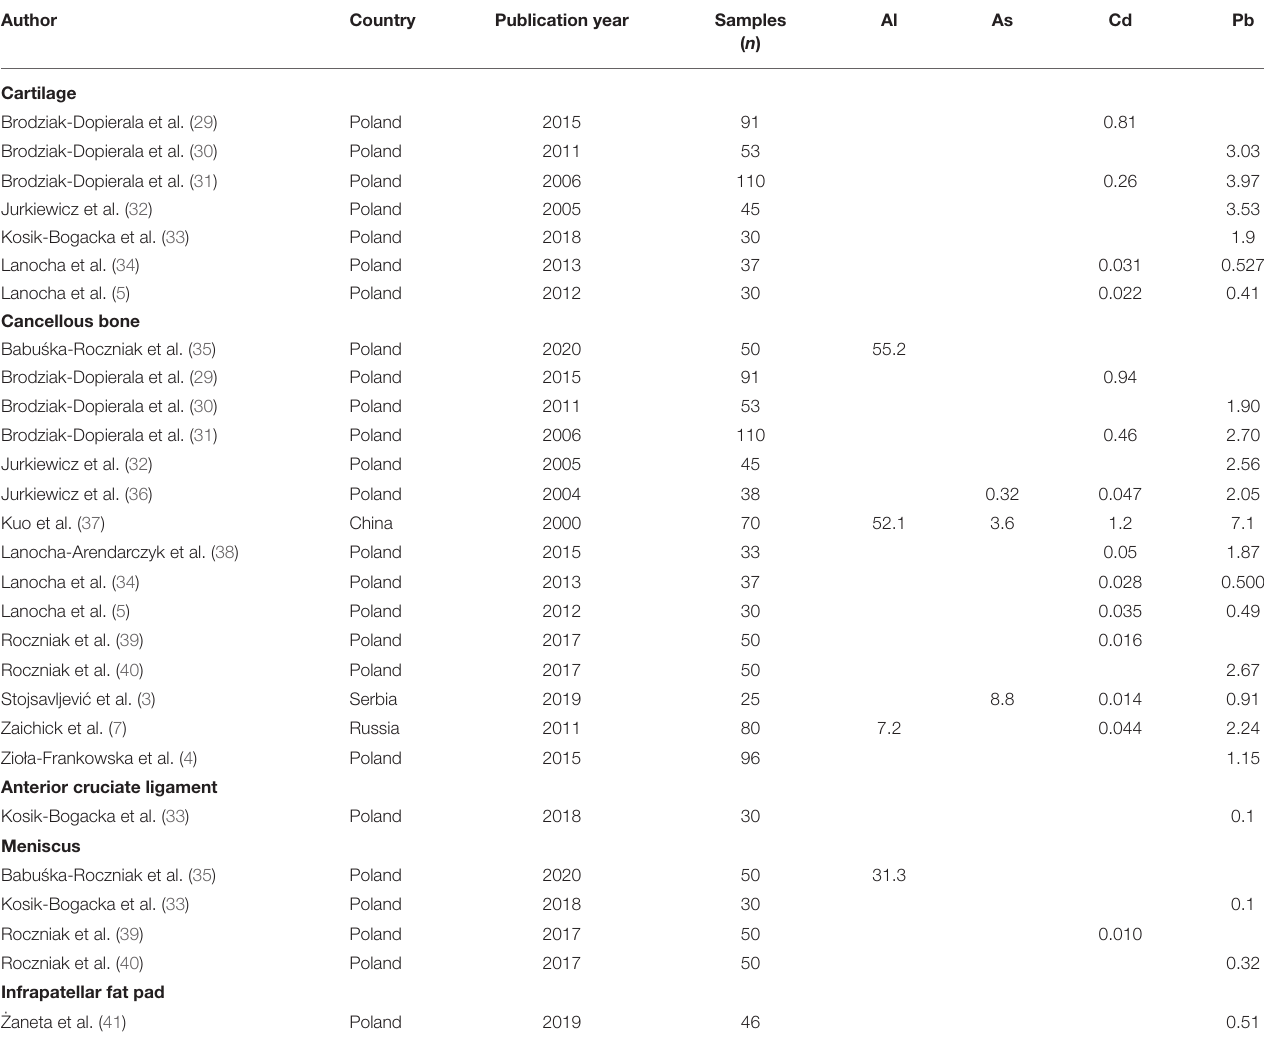
TABLE 1 | Mean concentrations of Al, As, Cd, and Pb in the cartilage, cancellous bone, anterior cruciate ligament, meniscus and infrapatellar fat pad in patients from various countries, based on literature